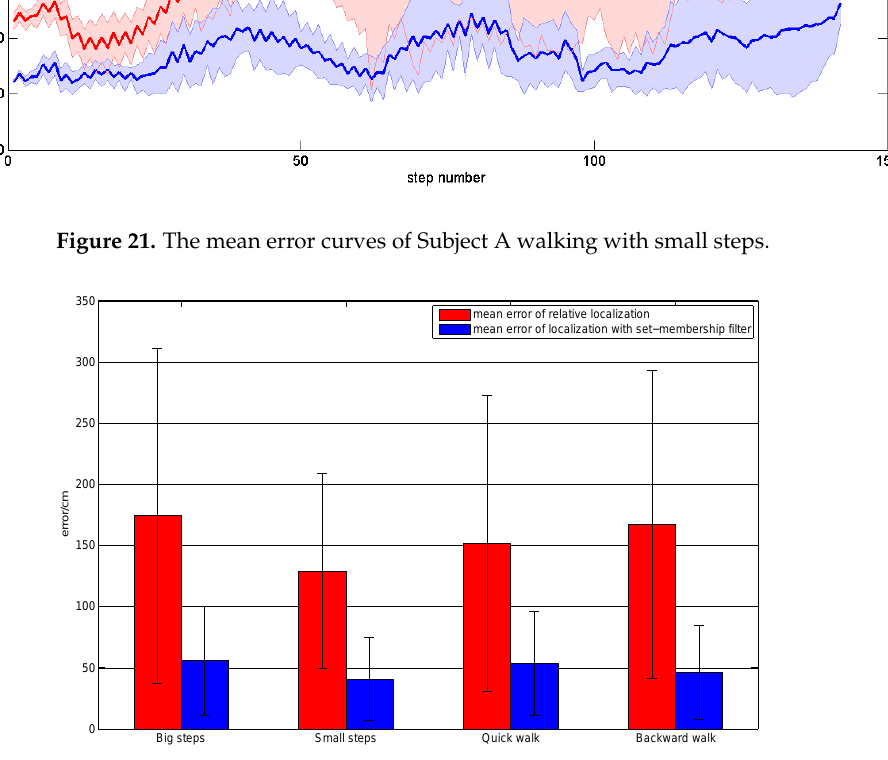
Figure 22. The mean (error bar) and standard deviation (black lines on the error bar) of the localization error of subject A in different walking